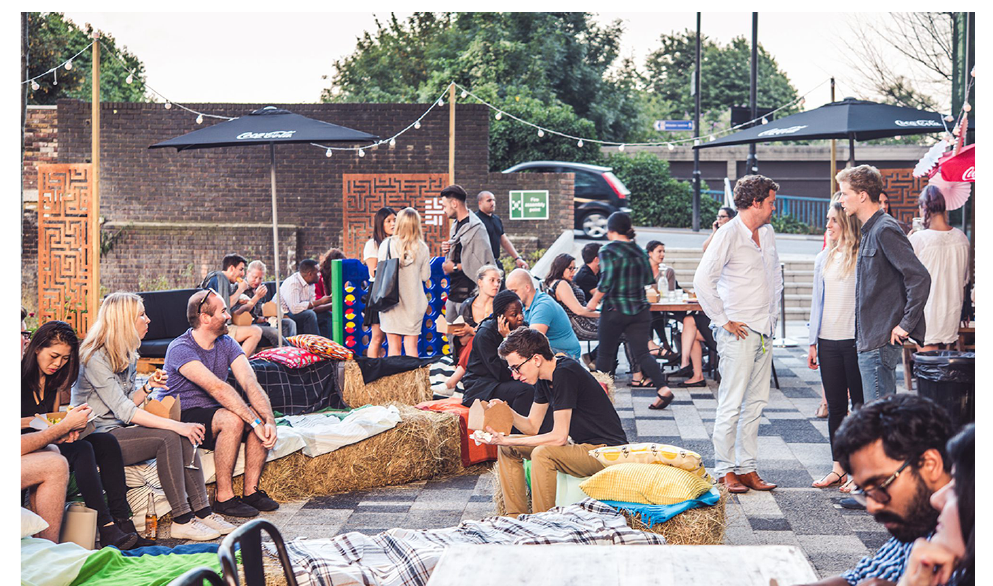
Figure 18. The Collective Co-living , London/New York. Source: The Collective (n.d.). Note: this promotional image highlights the community-oriented approach of co-living models.